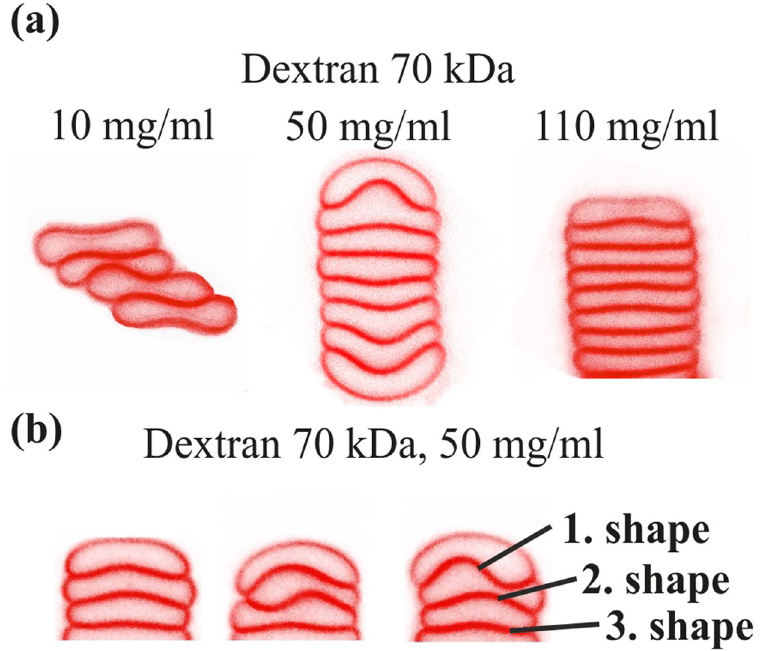
Figure 7. ( a ) Representative images of larger clusters (rouleaux) at different concentrations of dextran 70 kDa. ( b ) The first three interfaces show a large variation in shapes even at constant polymer concentration and we observe, male-female and